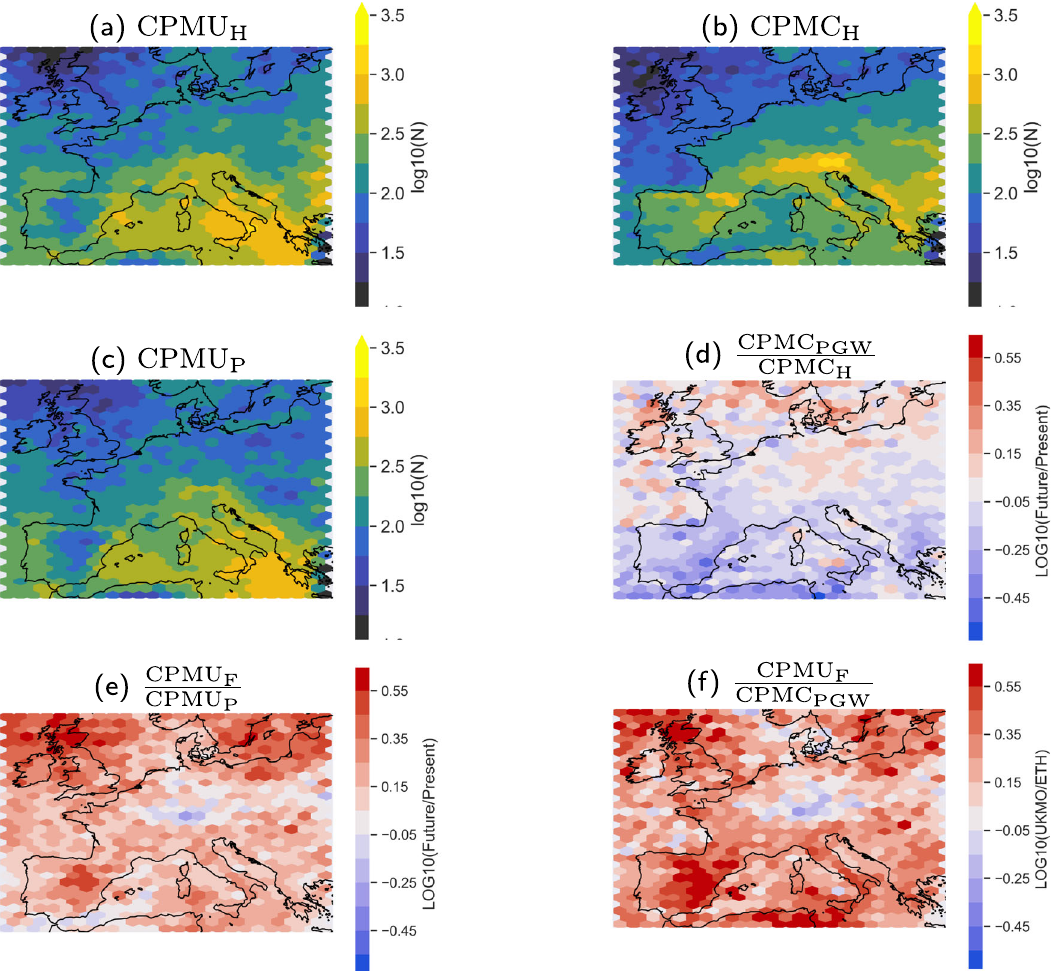
Fig. 2 Spatial frequency of MCSs across Europe. Shown are logarithm counts (log N ) for a , b UKMO and ETH hindcast, and c UKMO present-climate simulation in hexagon bins 76 . Future changes as logarithm ratios for d ETH (PGW/hindcast) and e UKMO (future/present) and f ratio of UKMO to ETH future